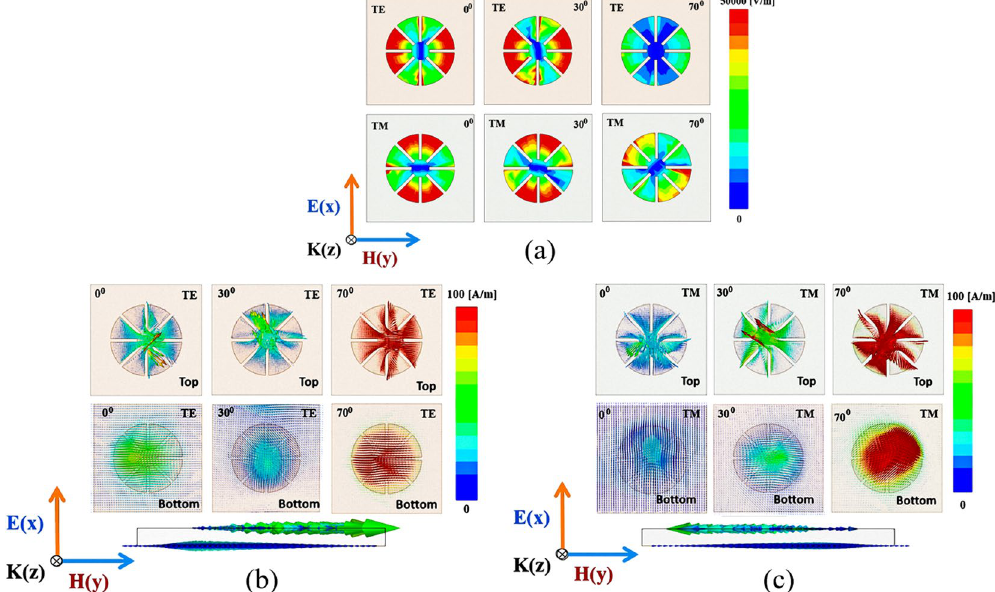
Figure 3. ( a ) Magnitude of electric-field distribution of the ECS unit cell: TE and TM modes under normal incidence ( θ = 0°) and under oblique incidence ( θ = 30° and θ = 70°). Simulated vector-current distribution of the top, bottom, and side of the ECS unit cell: ( b ) TE mode, ( c ) TM mode under normal incidence ( θ = 0°) and under oblique incidence ( θ = 30° and θ =